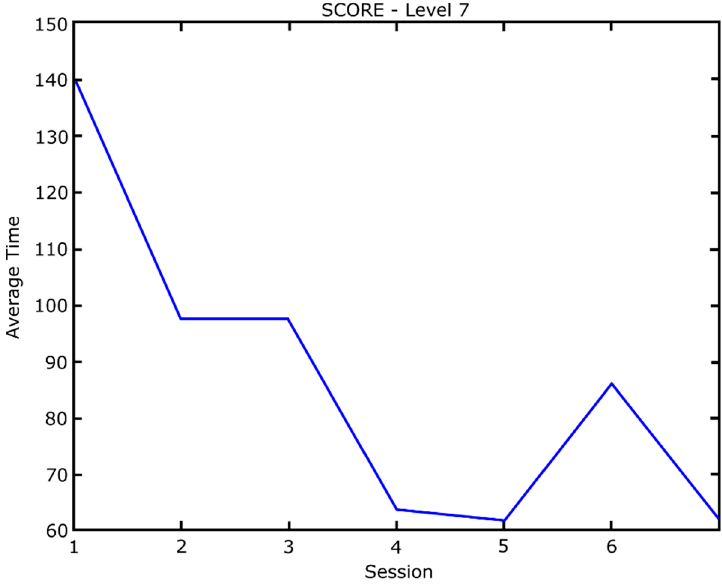
Figure 8. Execution times of “connect the dots” exercise.